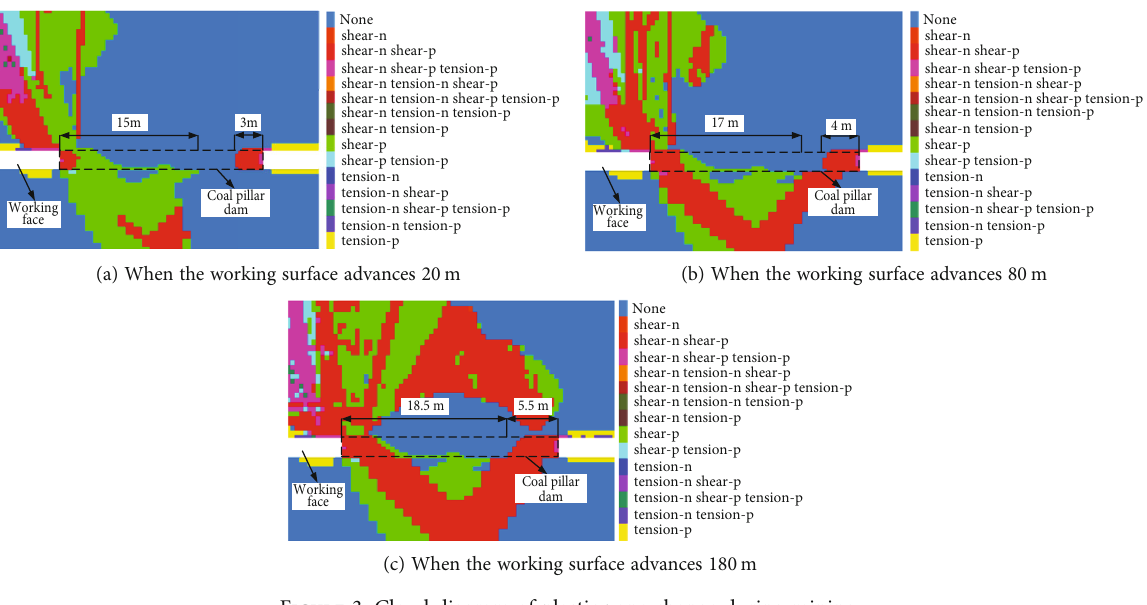
Figure 3: Cloud diagram of plastic zone change during